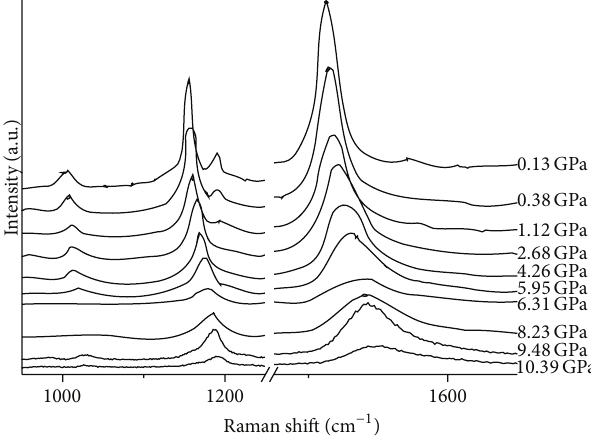
Figure 3: Resonance Raman spectra of canthaxanthin at different pressure in the spectral range of 950 cm −1 to 1650 cm −1